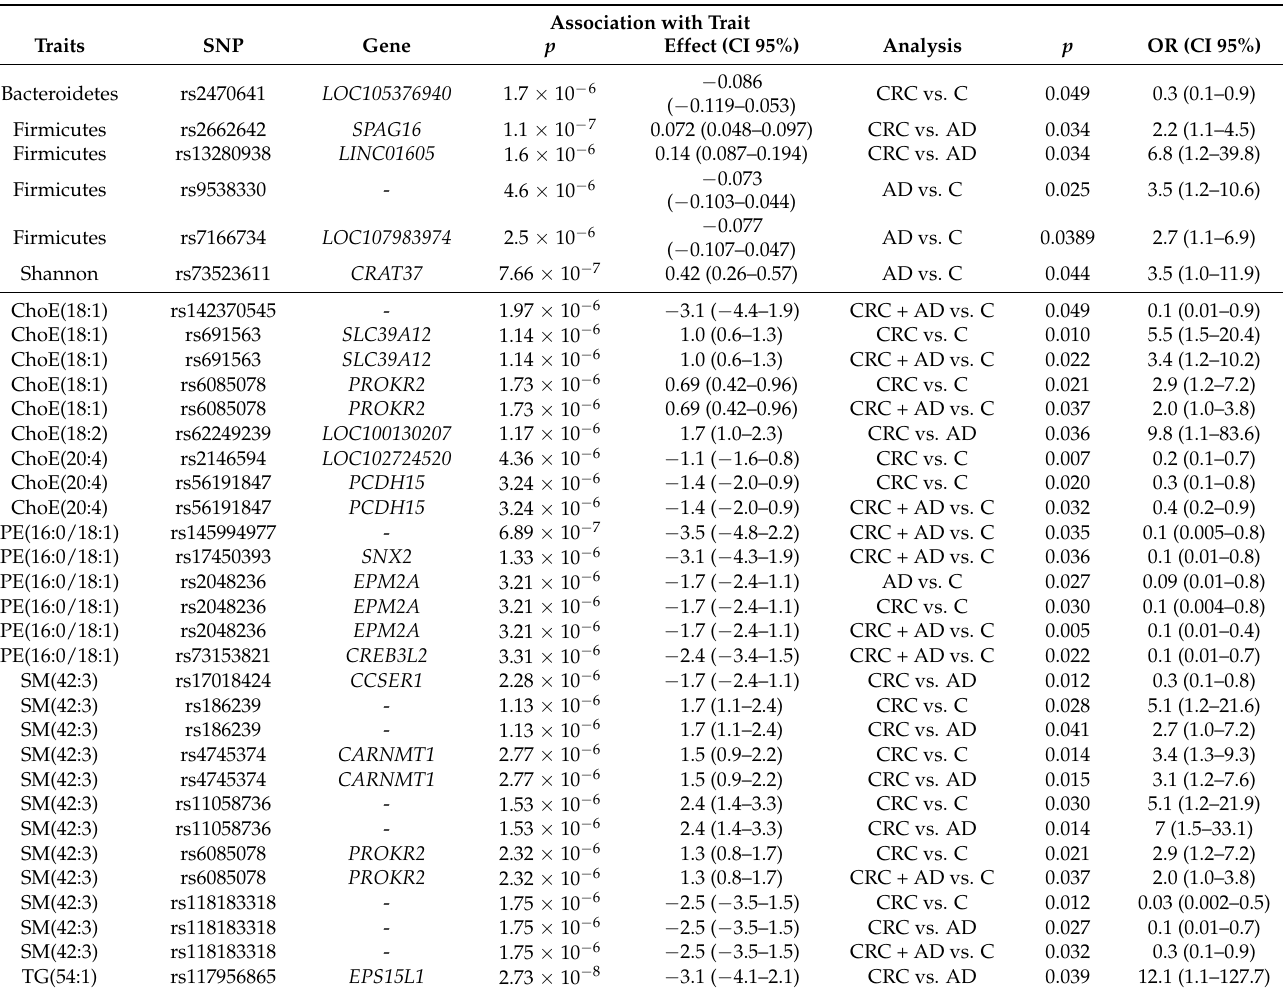
Table 3. Suggestive SNPs associated to microbiome and metabolome traits, which are significant ( p < 0.05) in adenoma or colorectal cancer. AD vs. C, adenoma vs. healthy controls; CRC vs. C, colorectal cancer vs. healthy controls; CRC vs. AD, colorectal cancer vs. adenoma; CRC + AD vs. C, adenomas and colorectal cancer vs. controls. OR, odds-ratio; CI 95%, 95% of confidence interval of effect or